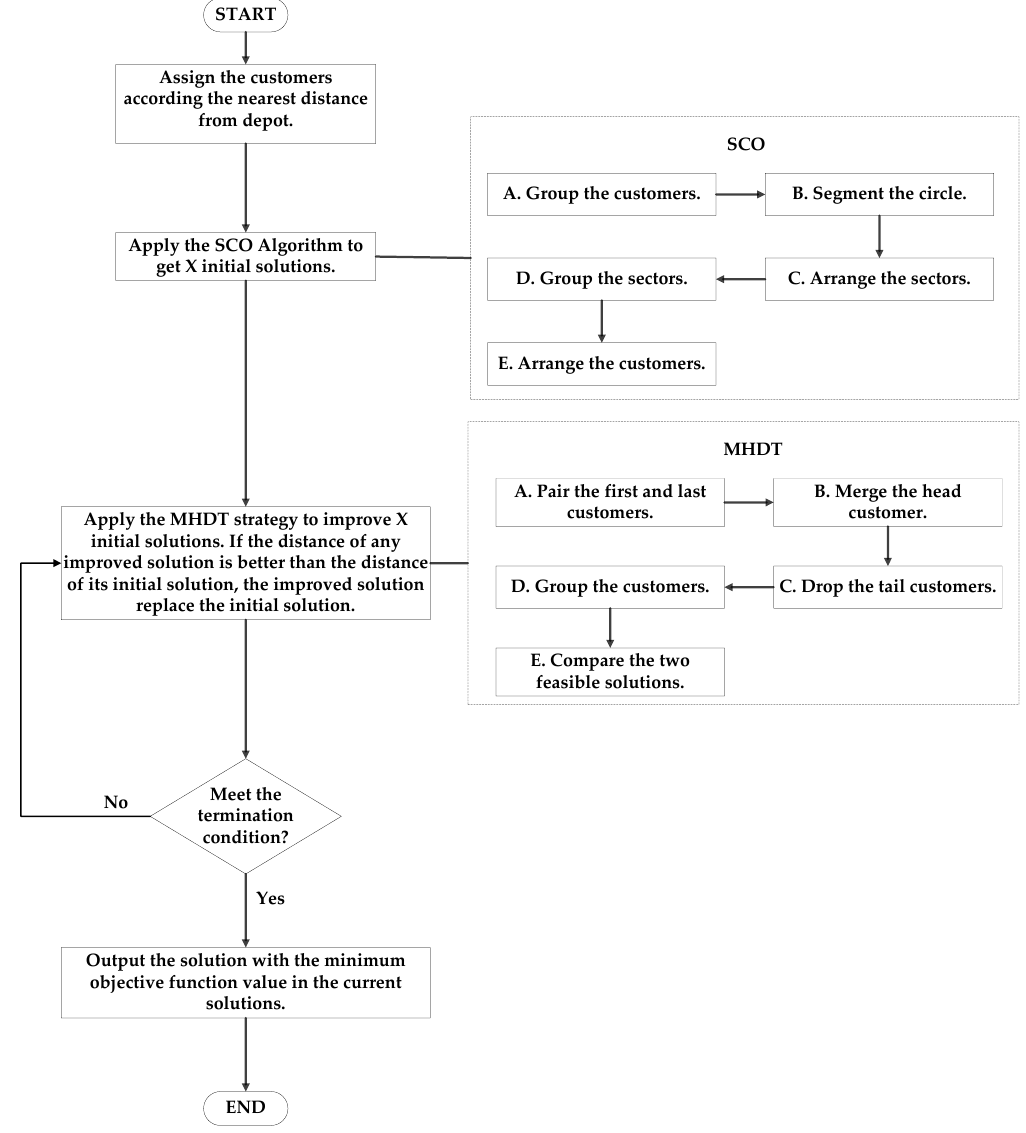
Figure 6. Flowchart of the whole procedure.